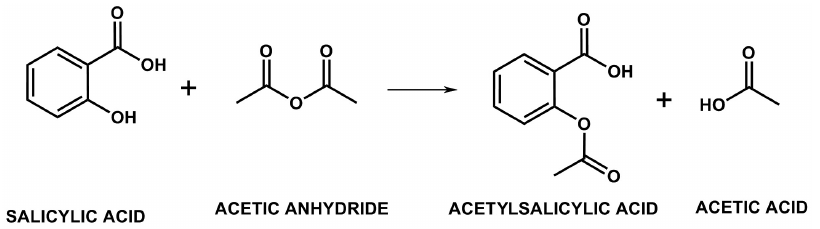
FIGURE 3 - Reaction of salicylic acid with acetic anhydride for the acquisition of acetylsalicylic acid and the release of acetic acid (the principal of